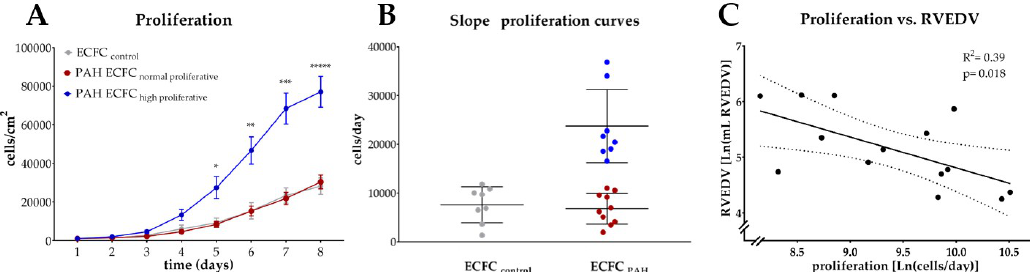
Figure 2. PAH ECFC have higher proliferative rates compared to ECFC from healthy control subjects, while ECFC proliferation is related to RVEDV. ( A ) Quantification of cell density ( y -axis, cells/cm 2 ) of ECFC of healthy subjects ( n = 8, grey) and PAH donors ( n = 18, red and blue) over time ( x -axis, days) indicates PAH ECFC proliferation is significantly higher compared to ECFC from healthy subjects, due to a subset of highly proliferative of PAH ECFC ( n = 8, blue). Two way repeated measurements ANOVA, p < 0.0001. Mean with standard error of mean (SEM) is shown. ( B ) Quantification of the steepness of individual growth curves ( y -axis, cells/day) indicates high proliferative PAH ECFC exceed the mean steepness of the growth curve of control ECFC by >2SD, where mean with SD is shown. ( C ) Individual steepness of the growth curve of PAH ECFC is correlated to RVEDV ( y -axis, Ln (RVEDV, mL), linear regression, R 2 = 0.39, p = 0.018, n = 14. 95% confidence interval (CI) is shown of Ln transformed